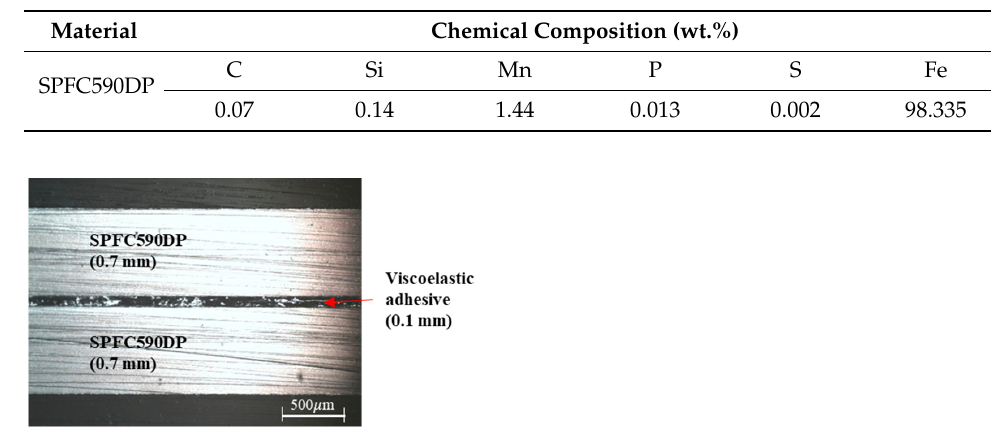
Figure 1. The cross-sectional view of the vibration-damping steel panel. Table 1. Chemical composition of the base steel alloy used in this study. Table 2. The tensile strength and the thickness of the materials used in this study.